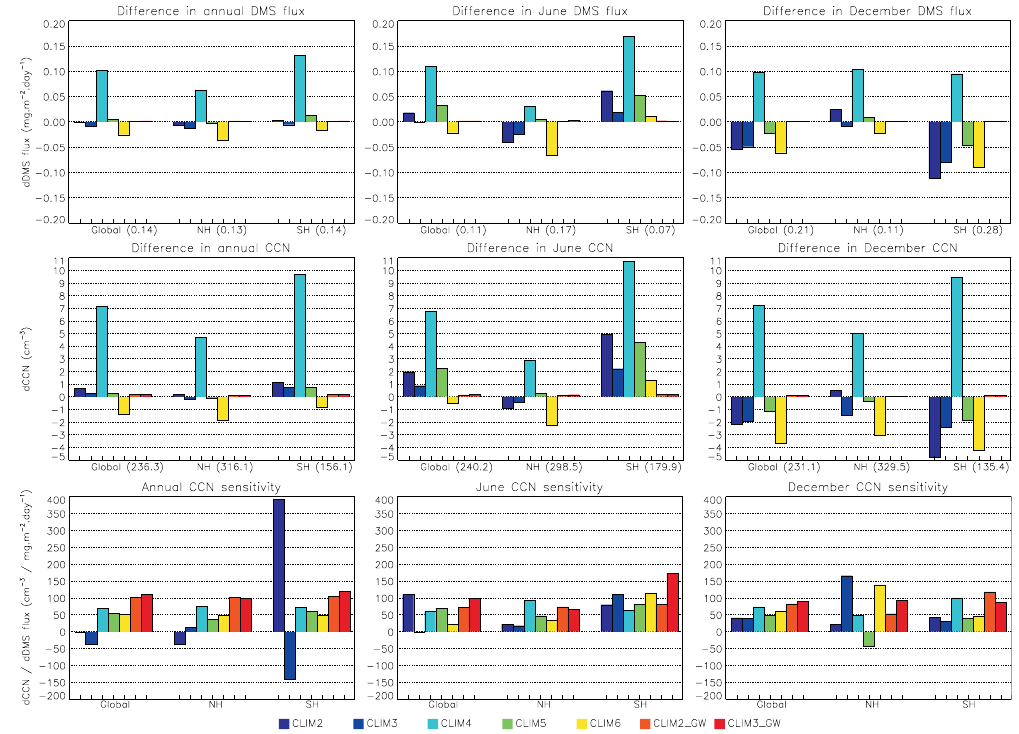
Fig. 4. Annual, June, and December mean absolute difference of DMS flux (in mgm − 2 day − 1 sulphur), concentration of CCN (number/cm 3 ) > 35nm dry radius at the surface, and absolute CCN sensitivity for the five present day climatologies, relative to CLIM1 with the Kettle and Andreae (2000) climatology, and for the GW scenarios relative to CLIM2 and CLIM3. DMS flux differences are ocean only, i.e. land areas are not included in the calculation of DMS fluxes. CCN values are an average over all areas. Numbers in brackets are global, NH and SH means for the CLIM1